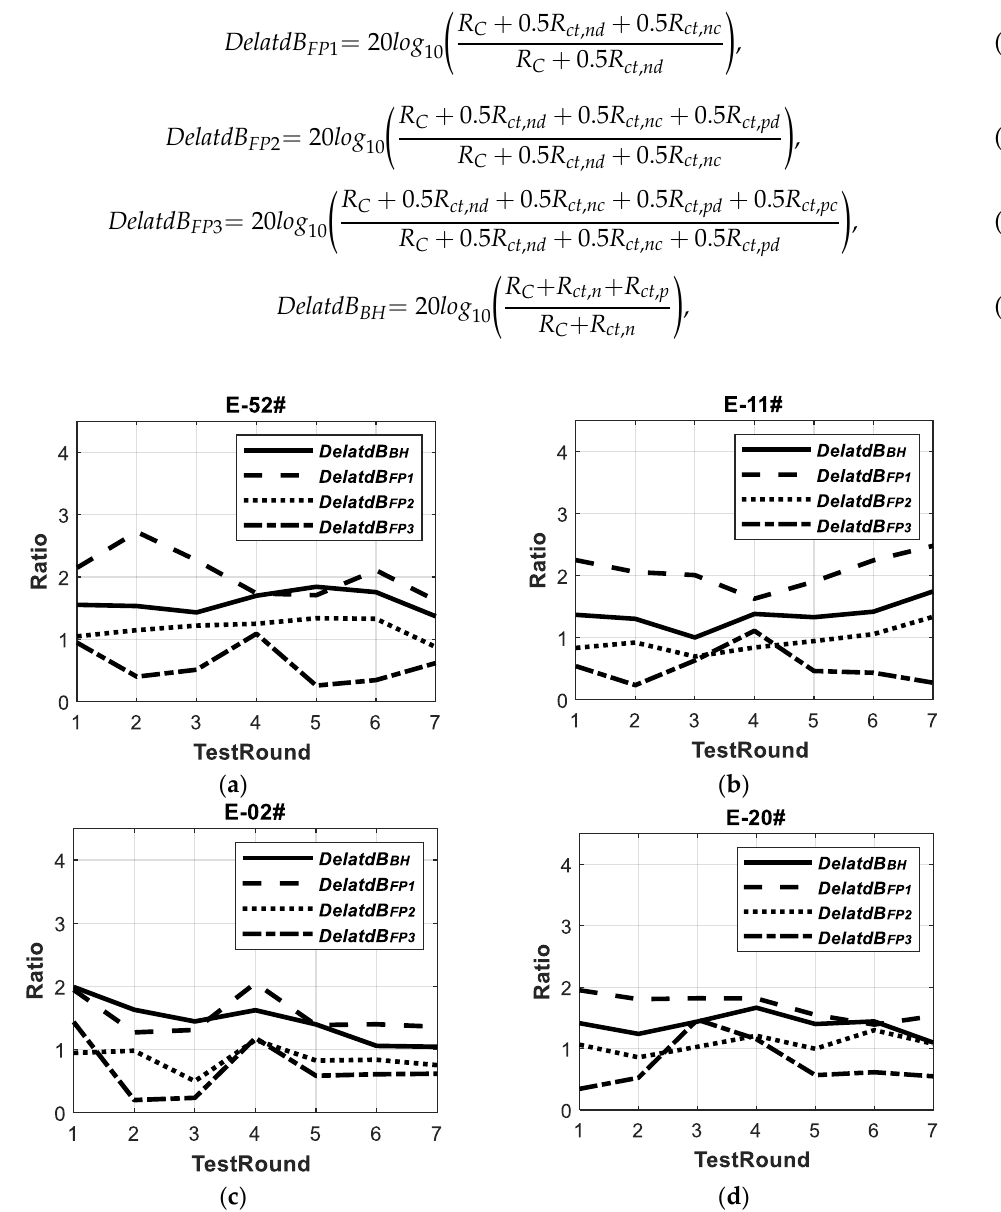
Figure 15. Ratio of decibel values of ascending steps of the sum of internal resistances: ( a ) E-52#; ( b ) E-11#; ( c ) E-02#; and ( d ) E-20#.